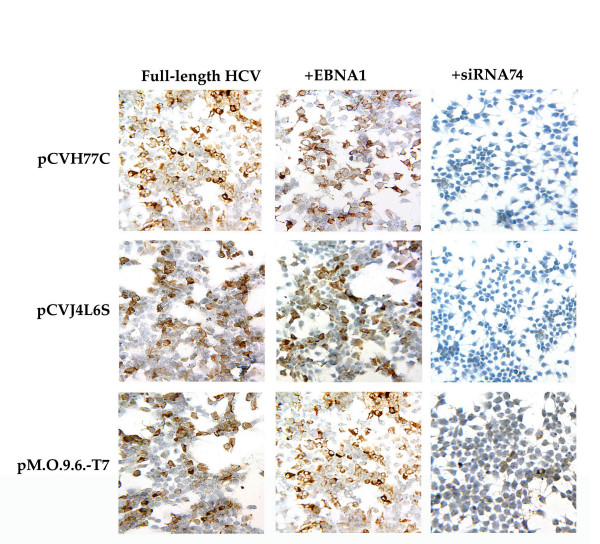
Immunocytochemical staining showing the silencing of core protein from full-length clones of HCV by siRNA-74. Huh-7 cells were co-transfected with (10 μg) pSuper-retro-siRNA74 and (10 μg) full-length clones of HCV. After 48 hours, transfected cells were harvested by the treatment with trypsin-EDTA. Cells were washed with PBS and immobilized onto a glass slide by cytospin method. Then slides were blocked and stained with core antibody against HCV using a mouse monoclonal antibody. Immunostaining for HCV core protein was performed using a standard protocol. The expression of core protein of full-length HCV 1a (pCVH77C), Ib (pCVJ4L6S), and 1b (pMO9.6--T7) is observed in the presence of siRNA74 and siRNAEBNA1 (unrelated siRNA).